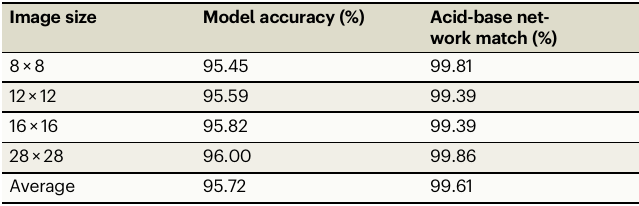
Table 2 | Matching accuracy for 2-class, binary image classi fi er Image size Model accuracy (%)